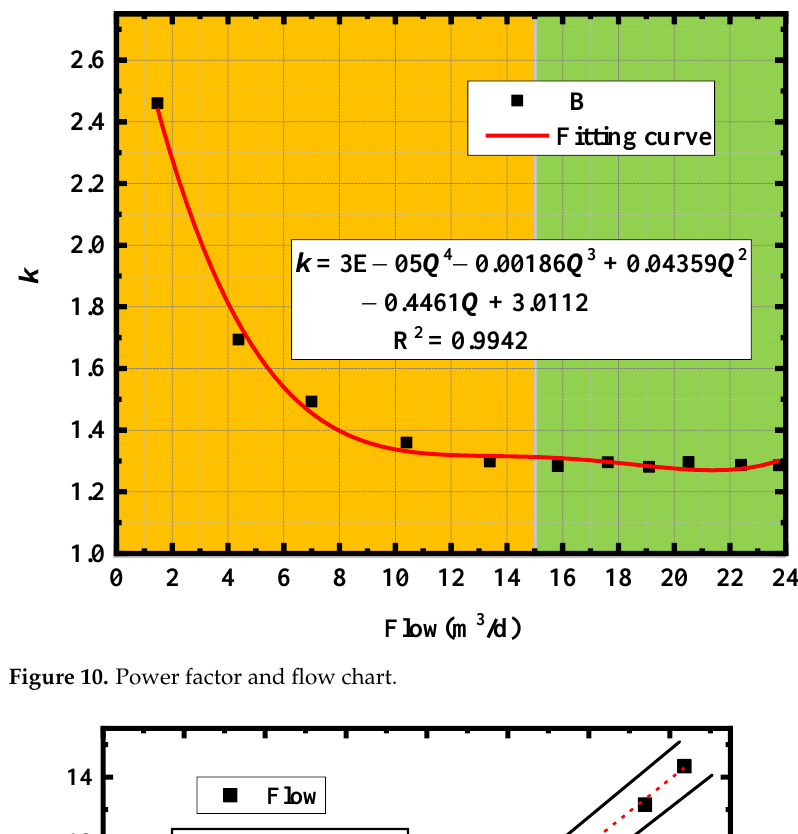
Figure 10. Power factor and flow chart.